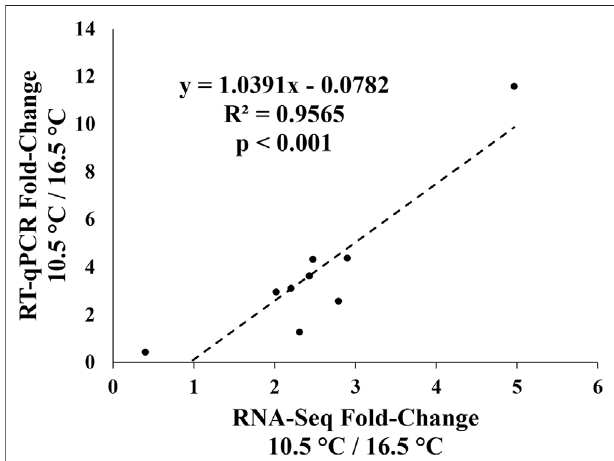
FIGURE 7 | Regression plot of transcript expression fold-changes between the 10.5 ° C and 16.5 ° C treatments calculated from the RNA-seq dataset (average between DESeq2 and edgeR) and normalized relative quantity (NRQ) values from the qPCR-validation.